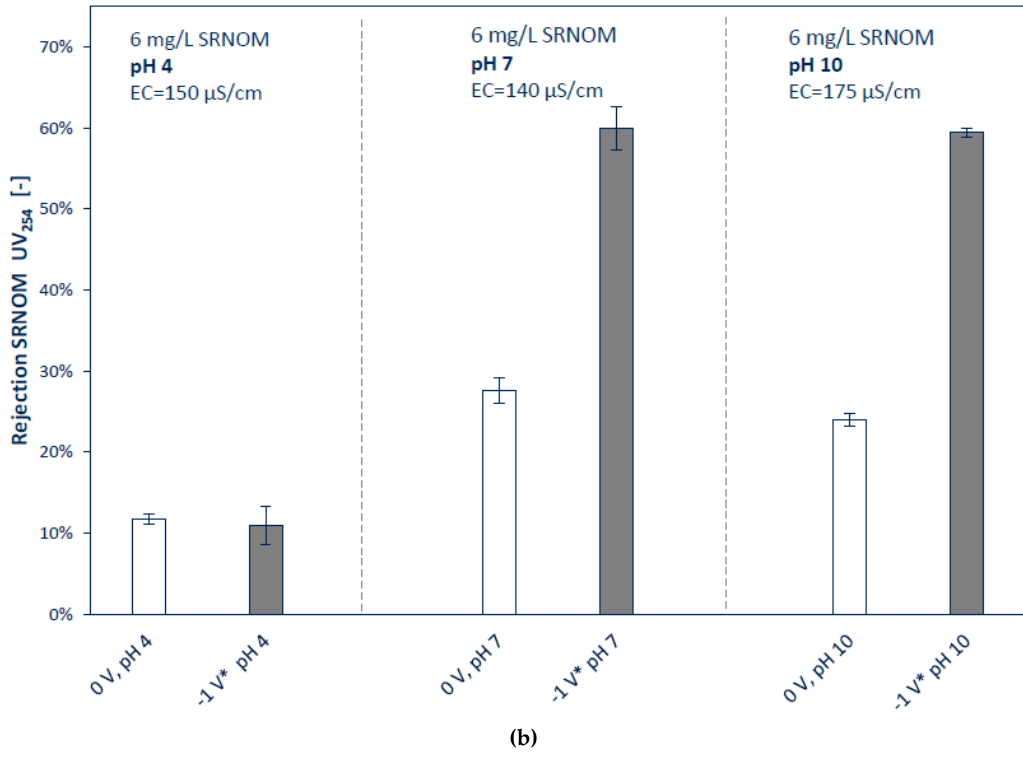
Figure 6. Influence of ionic strengths ( a ) and pH ( b ) on rejection; all experiments are conducted at least as triplicate with a membrane surface of 42 cm 2 , TMP of 0.1 MPa, cross-flow velocity of 0.16 m s − 1 , sample for rejection calculation is taken after filtration of 250 mL; feed: 6 mg L − 1 of SRNOM, pH 7, NaCl concentration of ( a ) 0, 1, 10 mmol L − 1 , ( b ) pH 4, 7 and 10; * all potentials are measured vs. Ag/AgCl reference electrode, error bars present standard deviations.